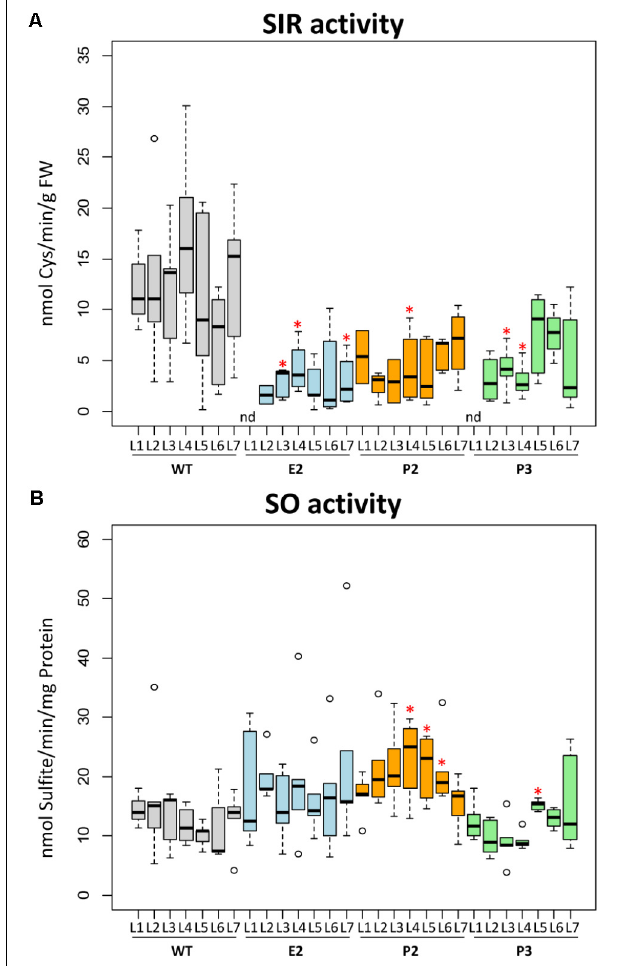
FIGURE 2 | SIR and SO activity. Boxplots show enzymatic activities of sulfite reductase (SIR) (A) and sulfite oxidase (SO) (B) . The top edge (hinge) of the box indicates the 75th percentile and the bottom hinge indicates the 25th percentile of data. The line in the box indicates the median value. The ends of the vertical lines (whiskers) indicate the minimum and maximum data values. Outliers are represented by an open circle. Differences between the wild-type and transgenic lines were analyzed using Student’s t -test and statistical significance was indicated ( ∗ P < 0.05). nd, not determined because below detection